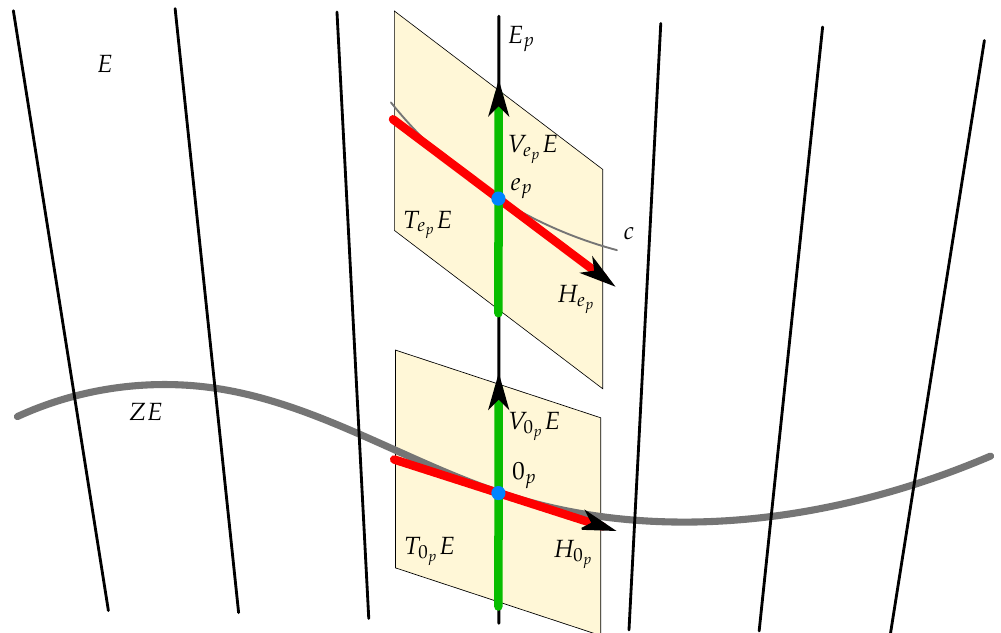
Figure 2. A diagram representing the decomposition of TE → E into horizontal and vertical subbundles. The vertical lines represent individual fibers of E , while p ∈ M , e p ∈ E p , 0 p ∈ E p denotes the zero vector of E p , and ZE denotes the zero subbundle of E ; ZE ∼ = M . By the equivariance property of the linear connection, ZE is a submanifold of E which is entirely horizontal (its tangent space is entirely composed of horizontal vectors). The tangent spaces T 0 green arrows representing the vertical subspaces (“along” the fibers), red arrows representing the horizontal subspaces. Finally, c is a horizontal curve passing through e p